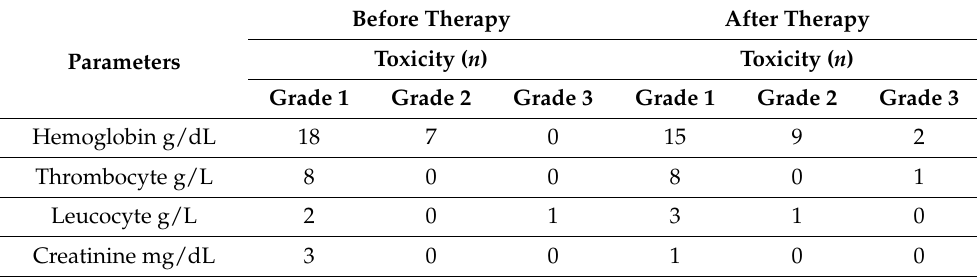
Table 3. Evaluation of treatment toxicities based on CTCAE version